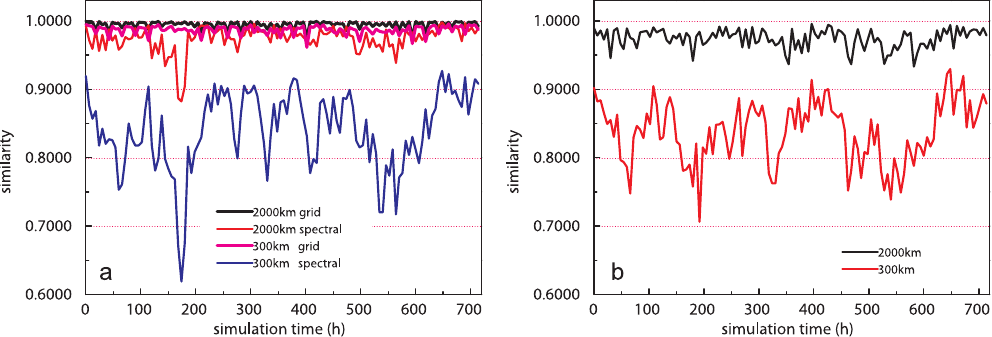
Fig. 3. Time series plots of similarity for horizontal kinetic energy at 850hpa, 2000km and 300km scales for July 2009. (a) similarity between NCEP/NCAP and downscaling results by WRF by grid and spectral nudging; (b) similarity between NCEP/NCAR and NARR